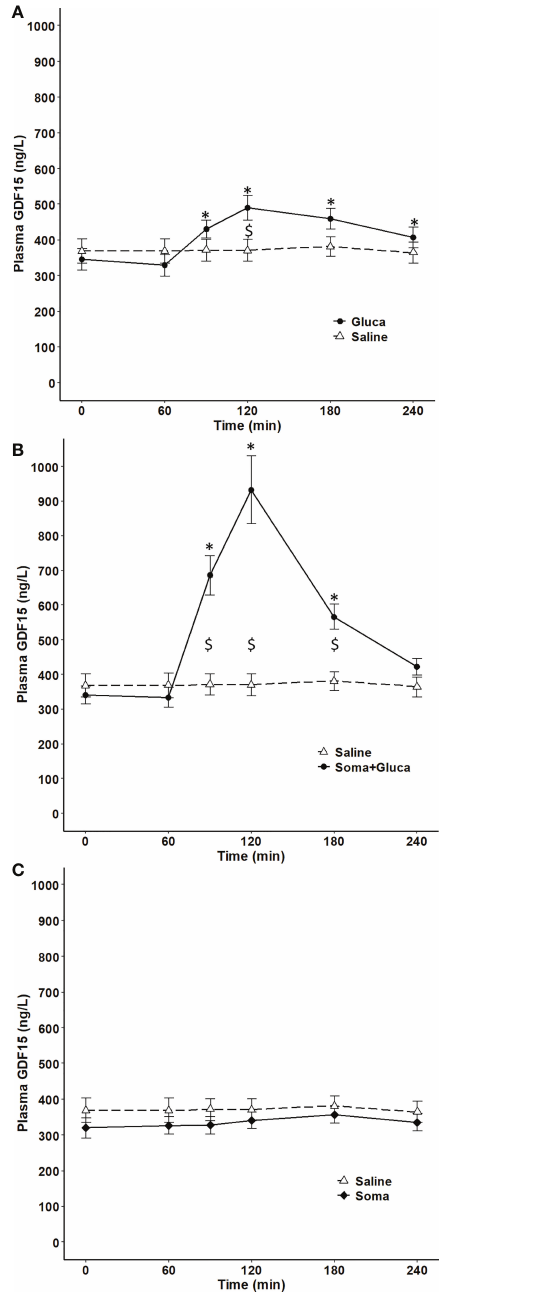
FIGURE 3 Plasma GDF15 in 10 healthy males completing 4 separate trials. On one day, the subjects received 1 hour of saline infusion (control condition) (broken line in A-C ). On other days, the subjects received a) Condition with elevated glucagon and insulin by 1 hour of glucagon infusion (0 – 60 min) (two-way ANOVA: Time P <0.0001, Group P= 0.3512, TimexGroup P< 0.0001) (B) Condition with elevated glucagon and reduced insulin by 1 hour of glucagon infusion (0 – 60 min) + somatostatin (-10 - 120 min) (two-way ANOVA: Time P < 0.0001, Group P= 0.0023, TimexGroup P< 0.0001) and (C) Condition with suppression of both glucagon and insulin by infusion of somatostatin (-10 – 120 min) (two-way ANOVA Time P=0.0562 Group P=0.3403 TimexGroup P=0.5728). Data are presented as means +/- SEM. * signi fi cantly different from timepoint “ 0 ” and “ $ ” indicates a difference between groups P< 0.05). Plasma concentrations of insulin, glucagon and glucose are published in Figure 4 in reference